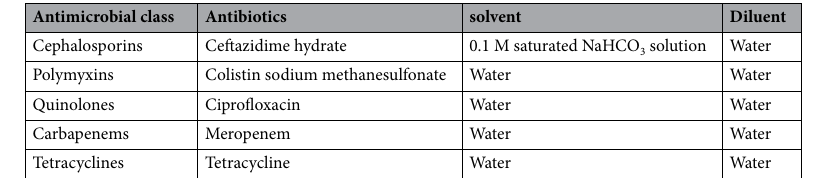
Table 3. The list of antibiotics used for MIC with their solvent and diluent (Andrews 34 ).